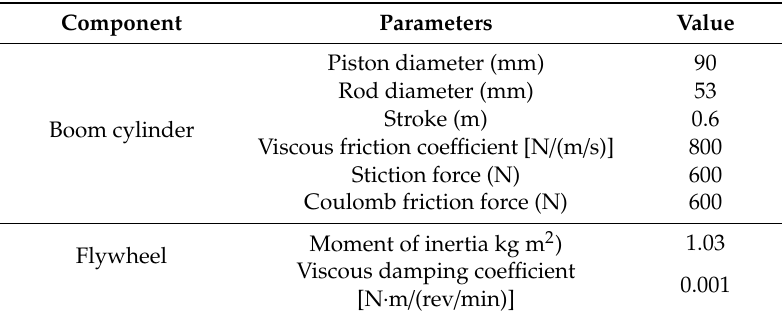
Table 3. Pertinent simulation parameters.